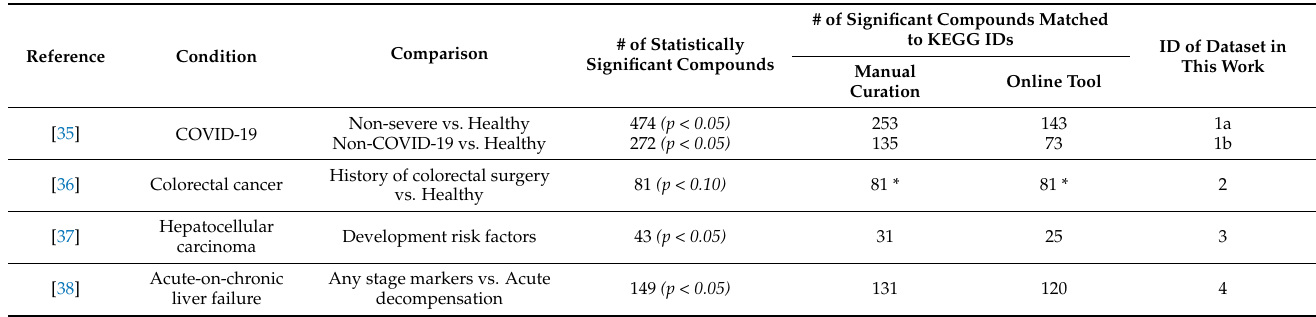
Table 1. List of datasets used in this